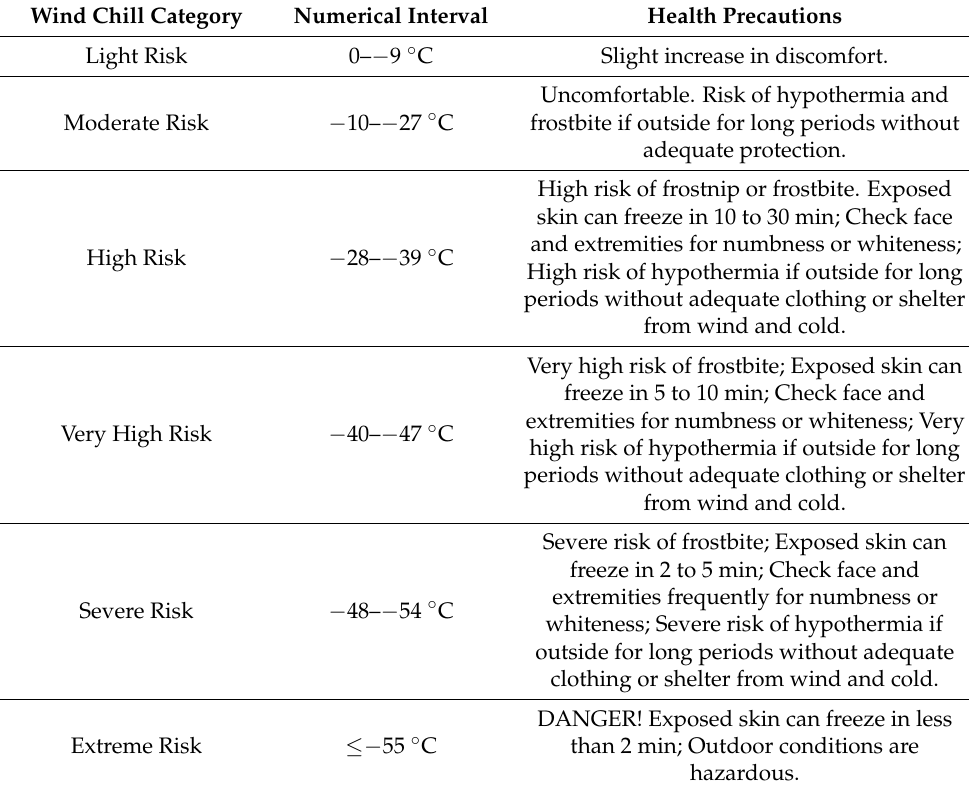
Table 4. Wind chill index categories and health